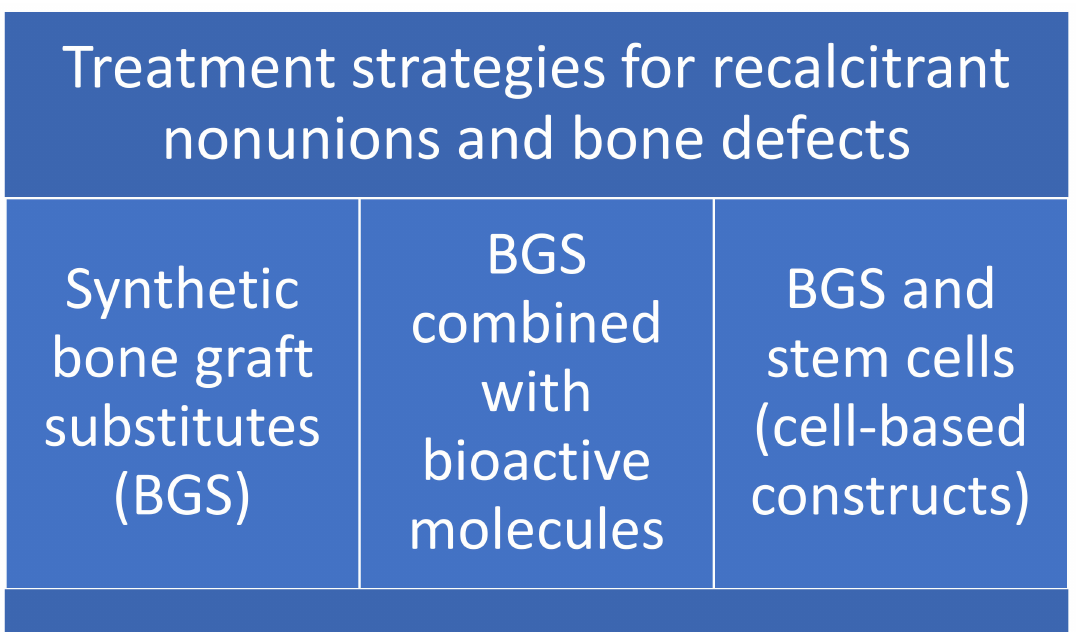
Figure 1. Main current strategies to treat bone defects and recalcitrant nonunions.